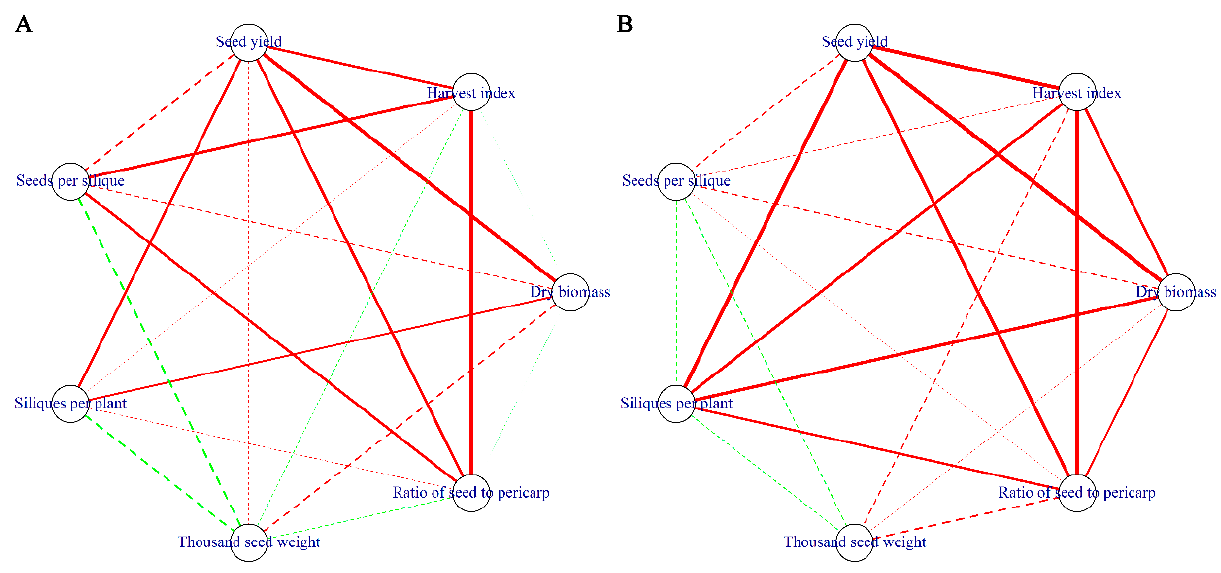
Figure 4. Correlation analysis for the yield component traits and plant dry biomass of the growing seasons 2020–2021 ( A ) and 2021–2022 ( B ). Red lines indicate a positive correlation (0 < r ≤ 1) and green lines indicate a negative correlation ( − 1 ≤ r ≤ 0). Solid and dashed lines indicate p ≤ 0.05 and p > 0.05, respectively.